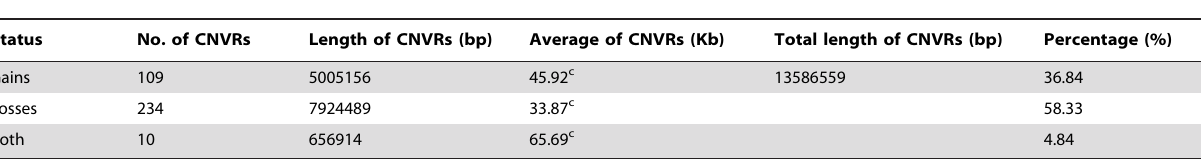
Table 3. Characteristics of the